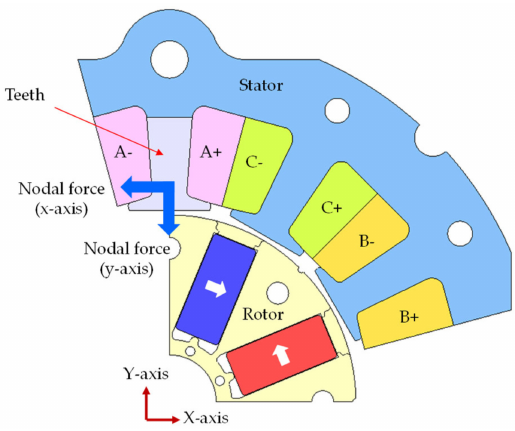
Figure 5. Nodal force components of the stator teeth.